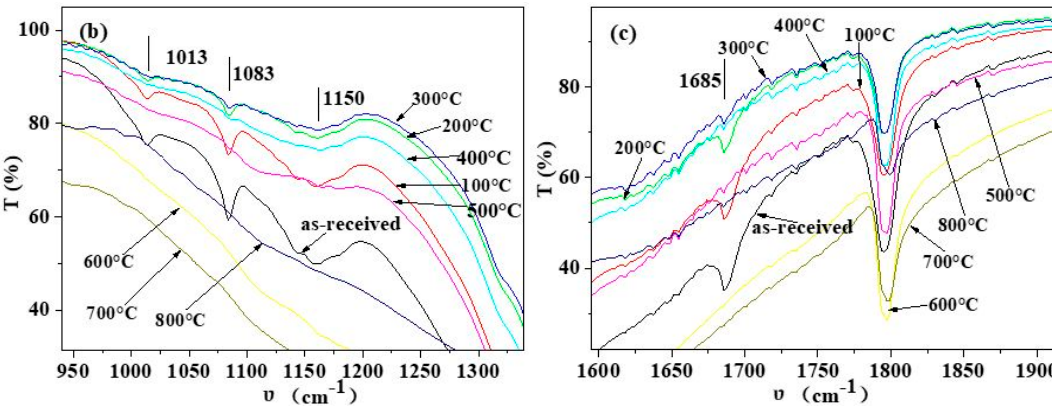
Figure 4. FT-IR spectra of shell powder calcined at different temperatures. ( a ) Full image, ( b ) enlarged the image of zone R1, ( c ) enlarged image of zone R2.